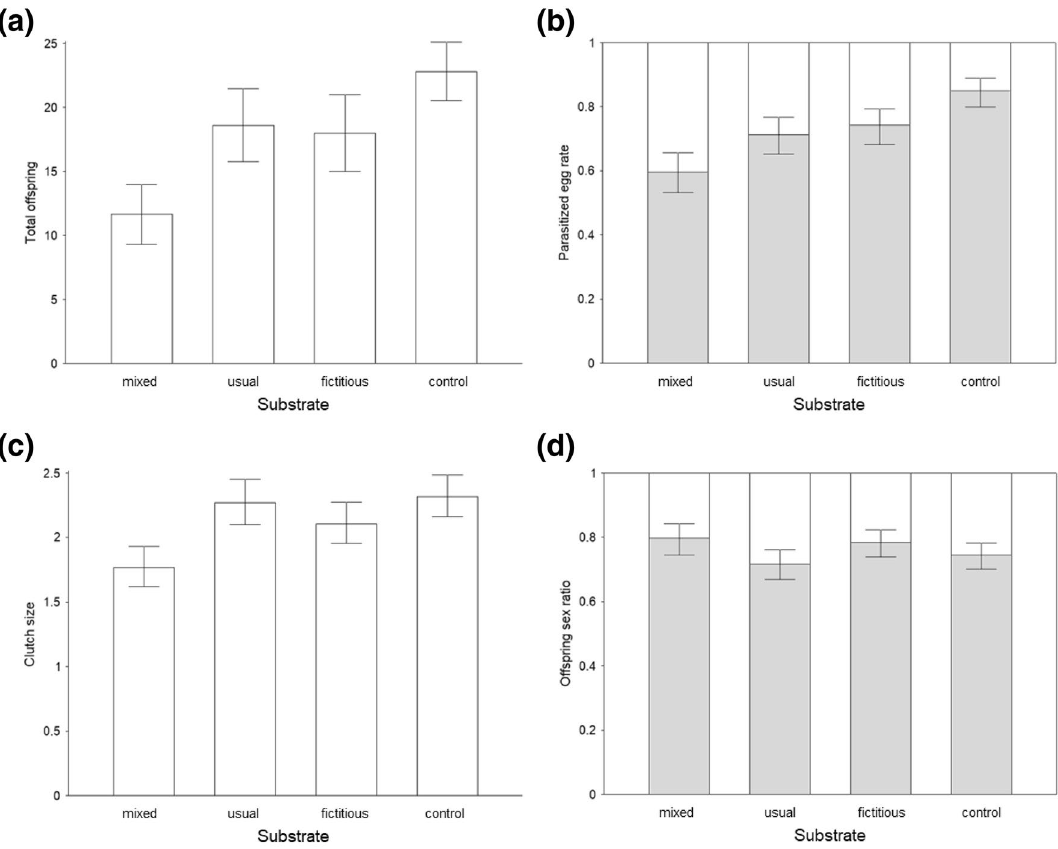
Figure 1. Effect of host egg substrate (mixed, usual host plant (crop), fictitious host plant (broad-leaved dock), control substrate (filter paper)) on reproductive strategy of A. flavipes : ( a ) offspring sex ratio (grey: females, blank: males), ( b ) parasitized host egg rate (grey: parasitized), ( c ) clutch size (i.e. offspring per parasitized host egg), and ( d ) total number of offspring per female. Mean values and 95% confidence